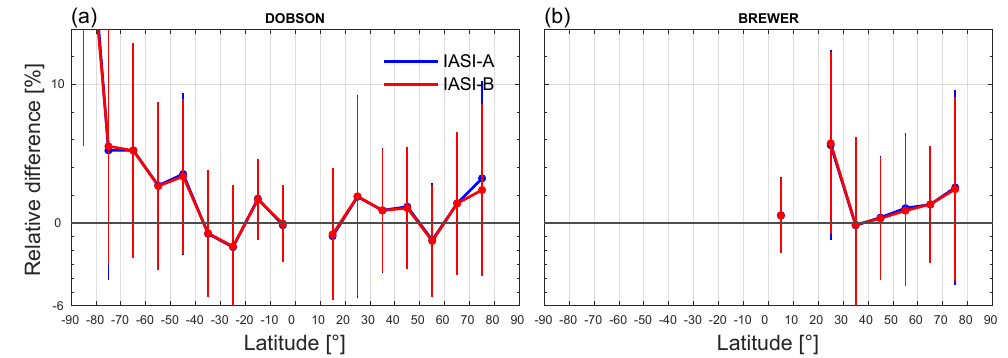
Figure 9. Latitudinal variability of the relative difference (in percent) between IASI-A (blue) and IASI-B (red) against collocated Dobson (a) and Brewer (b) TOC data given in bins of 10 ◦ . Only the common collocations between the two satellites are shown (May 2013–July 2017 period). The 1 σ standard deviation of the relative differences is also displayed (vertical bars). The relative difference is calculated as 100 × (IASI − GB) / GB [%].